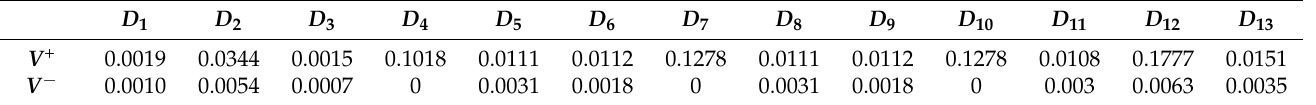
Table 7. 𝑉 + and 𝑉 − values of various indicators. Table 7. V + and V − values of various indicators.